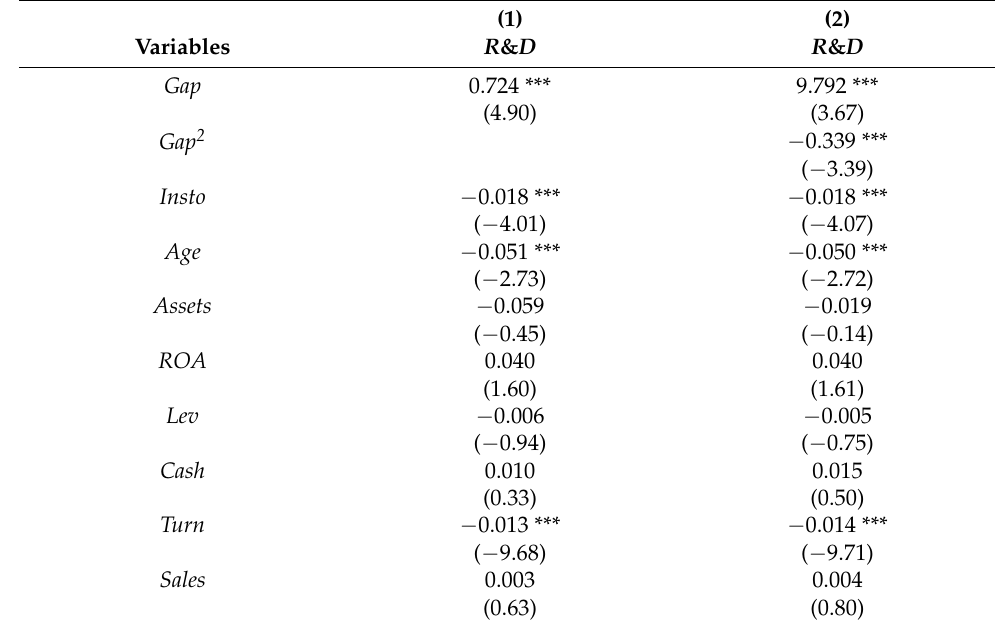
Table 4. Robustness test: different measures of internal compensation